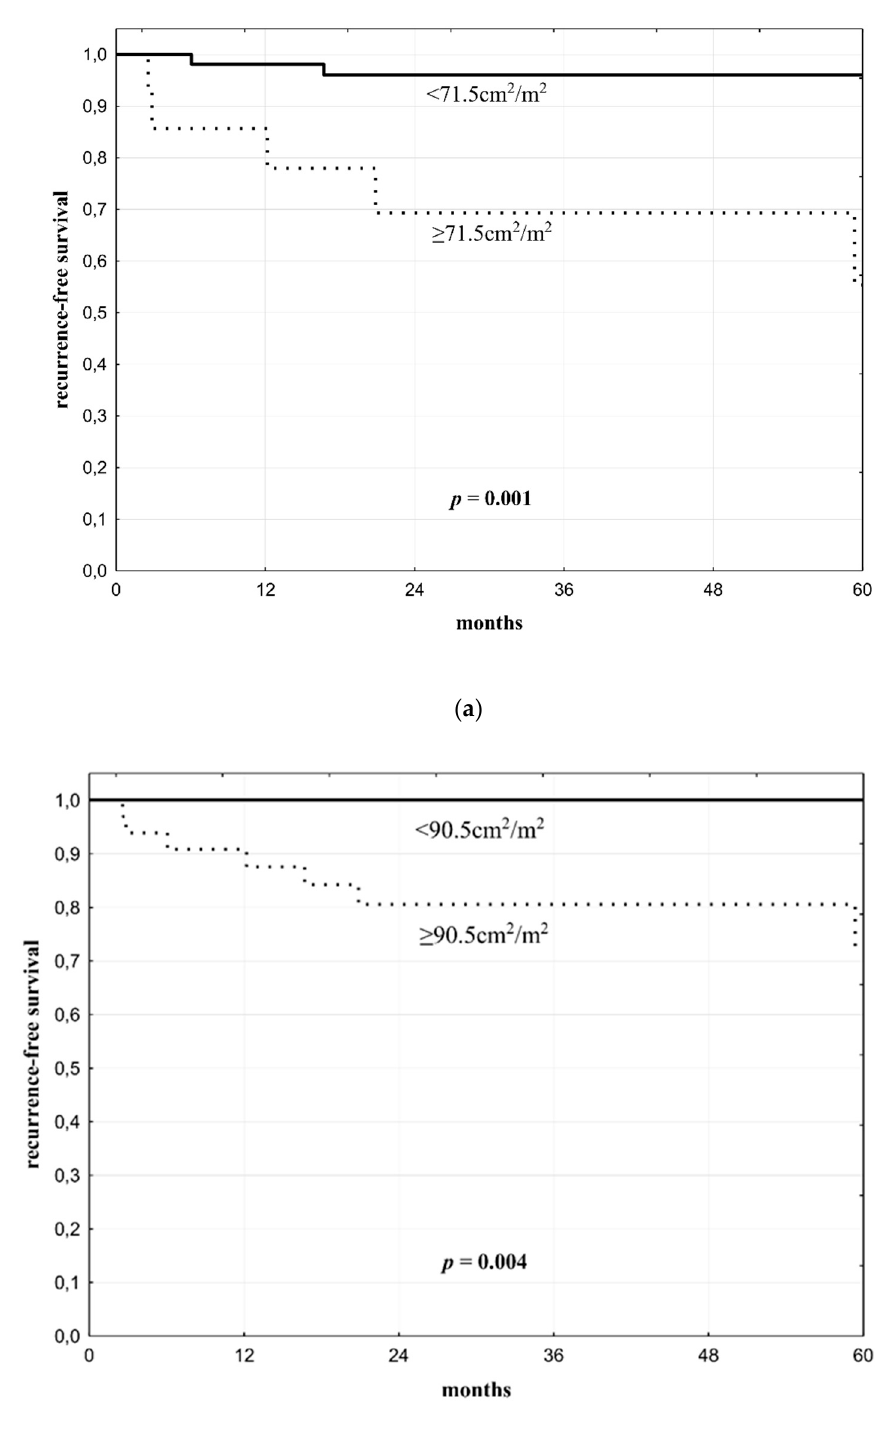
Figure 3. Recurrence-free survival after liver transplantation in HCC patients with ( a ) subcutaneous fat area <71.5cm 2 /m 2 and ≥ 71.5cm 2 /m 2 and ( b ) total fat area <90.5 cm 2 /m 2 and ≥ 90.5 cm 2 /m 2. . ( a ) Patients with the amount of subcutaneous fat area above the cut-off value had lower recurrence-free survival rates ( b ) Patients with the amount of total fat area above the cut-off value had lower recurrence-free survival rates